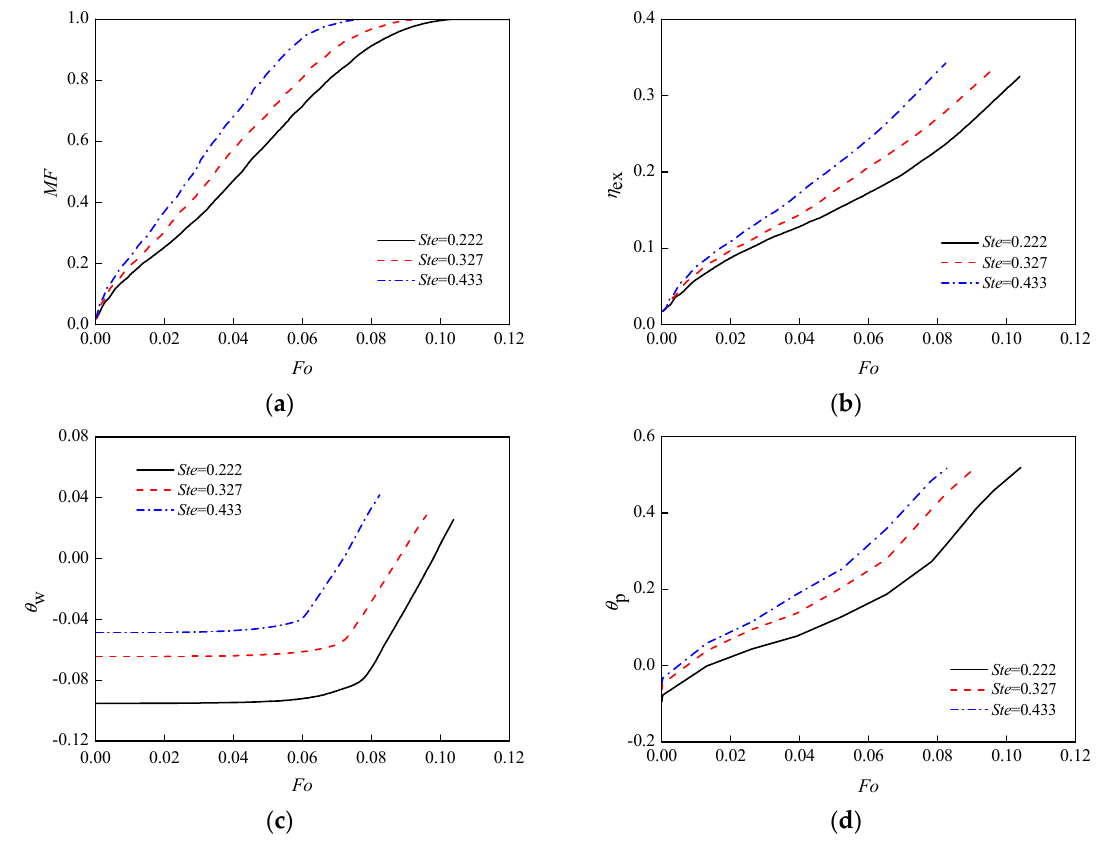
Figure 8. Evolution of the performance parameters for varying Stefan numbers: ( a ) melting fraction; ( b ) exergy efficiency; ( c ) water temperature; ( d ) paraffin temperature.